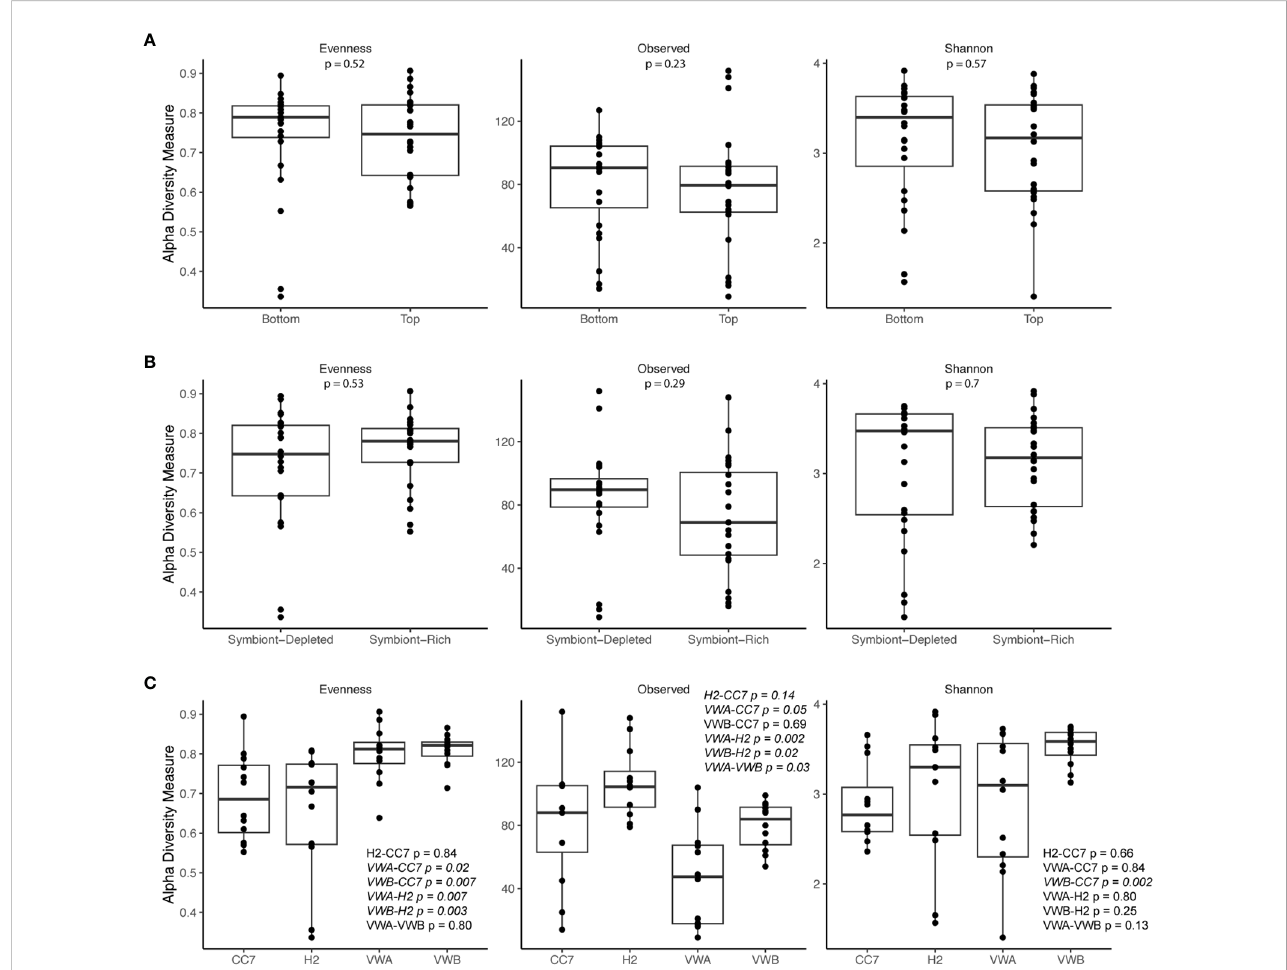
FIGURE 2 Alpha diversity metrics (Observed, Shannon ’ s index, Pielou ’ s evenness) of bacterial communities from body parts (A) , symbiotic states (B) , and genets (C) . The bar represents the median. Outer boundaries of the box represent fi rst and third quartiles. Points represent individual samples. P-values are based on pairwise Wilcox rank-sum tests using FDR correction, with values < 0.05 italicized.